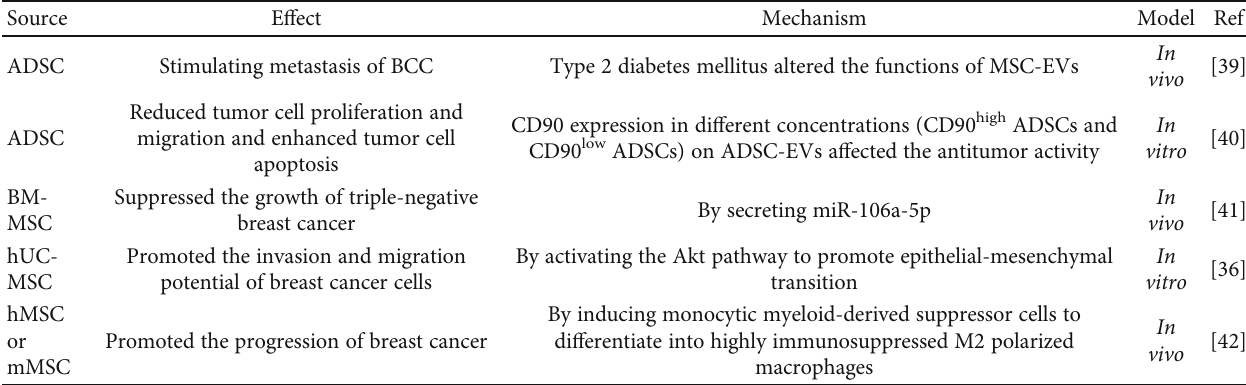
Table 1: E ff ects and mechanisms of MSC-EXs on breast cancer.